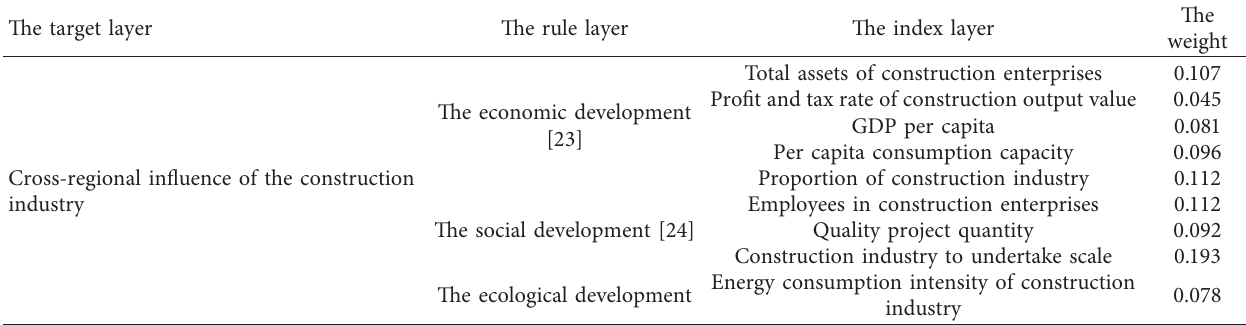
Table 1: Evaluation index system of cross-regional influence of construction industry. The target layer The rule